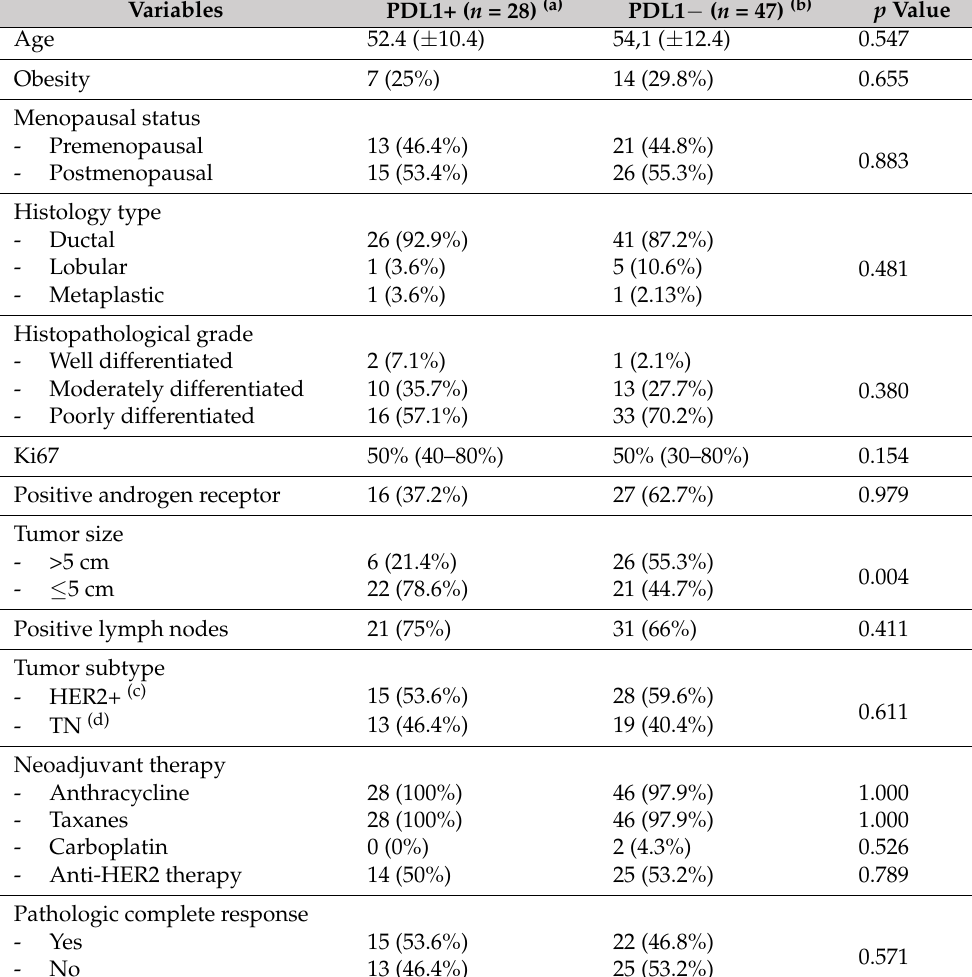
Table 3. Relationship between PD-L1 expression and clinicopathological characteristics in breast cancer